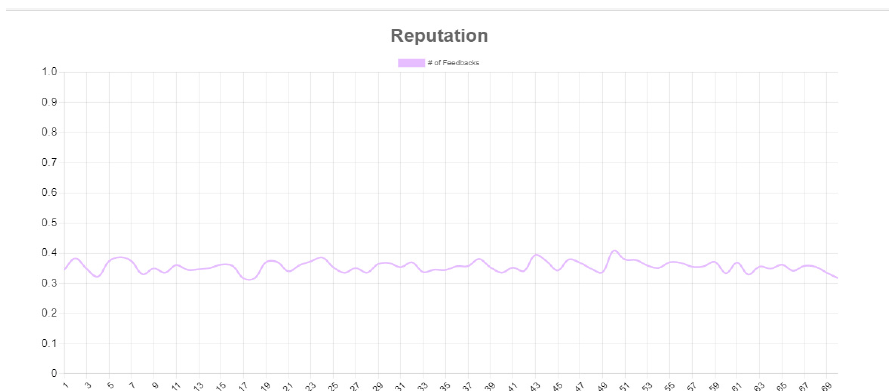
Figure 7. Reputation Chart for SP4.